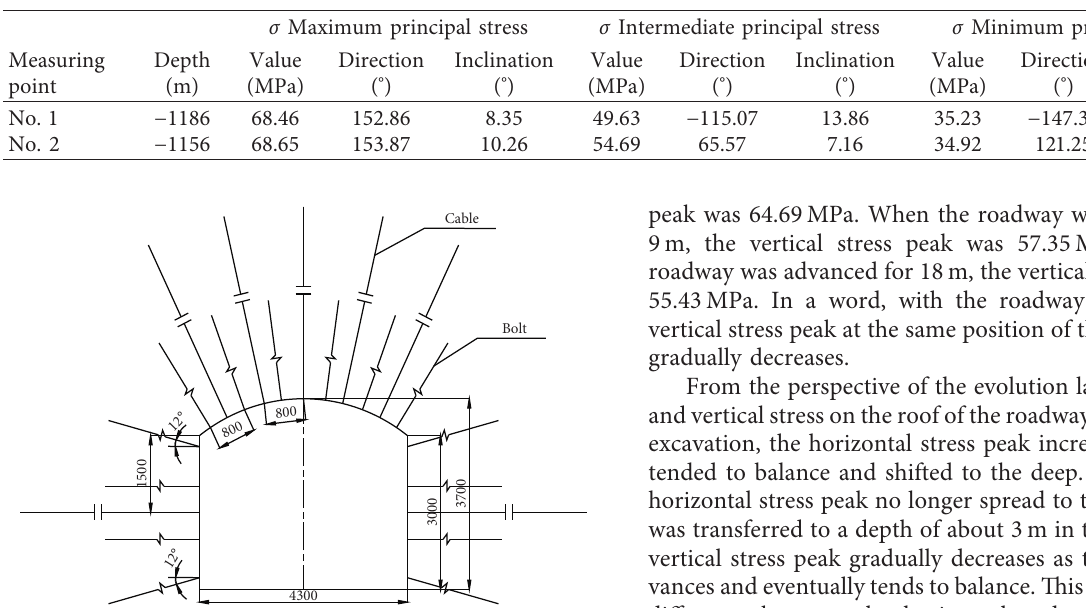
Table 1: Initial ground stress of Xingcun coal mine.